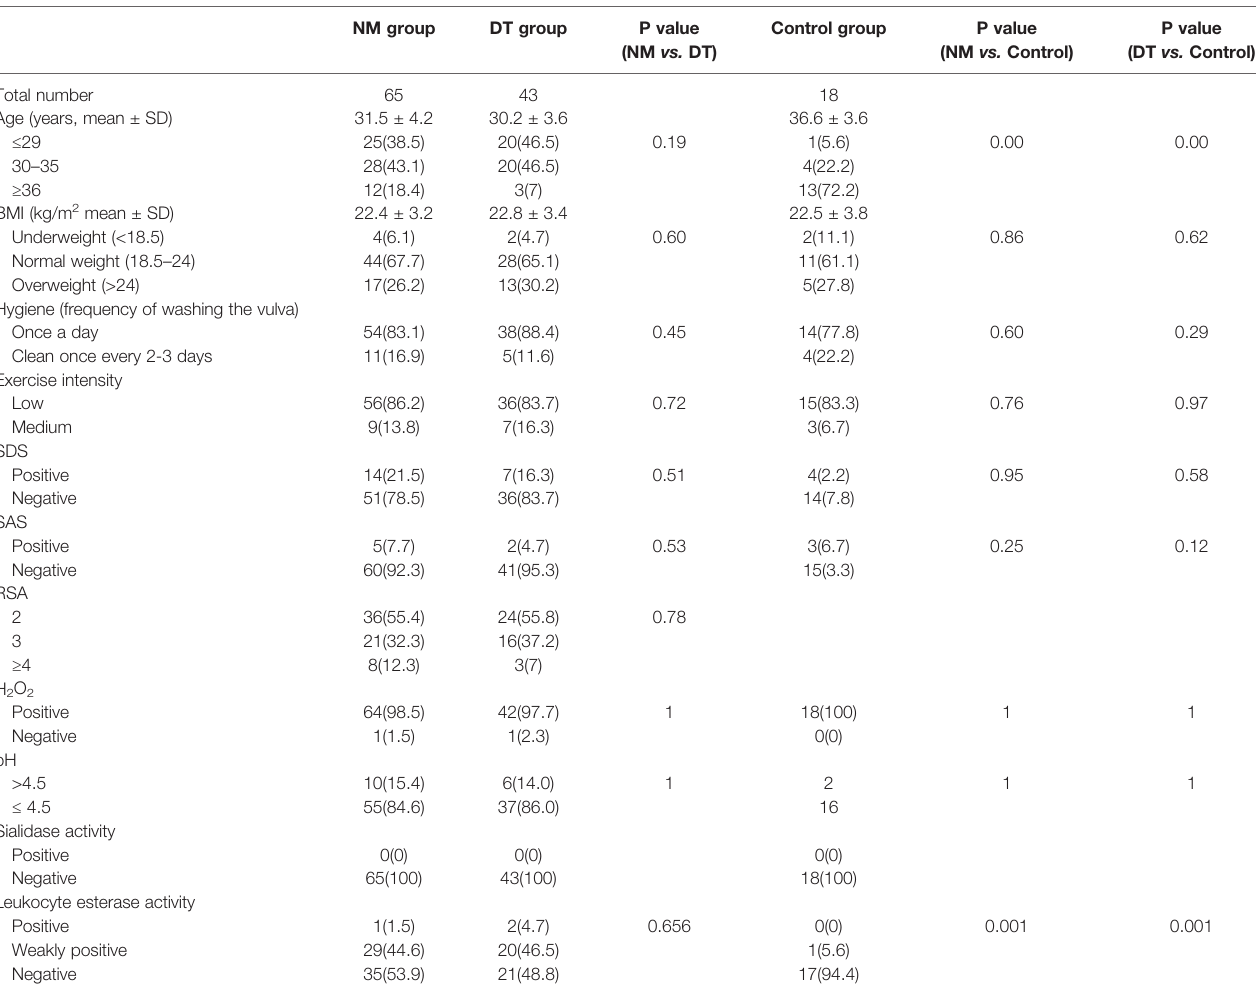
TABLE 1 | Clinical and demographic characteristics of the study population.